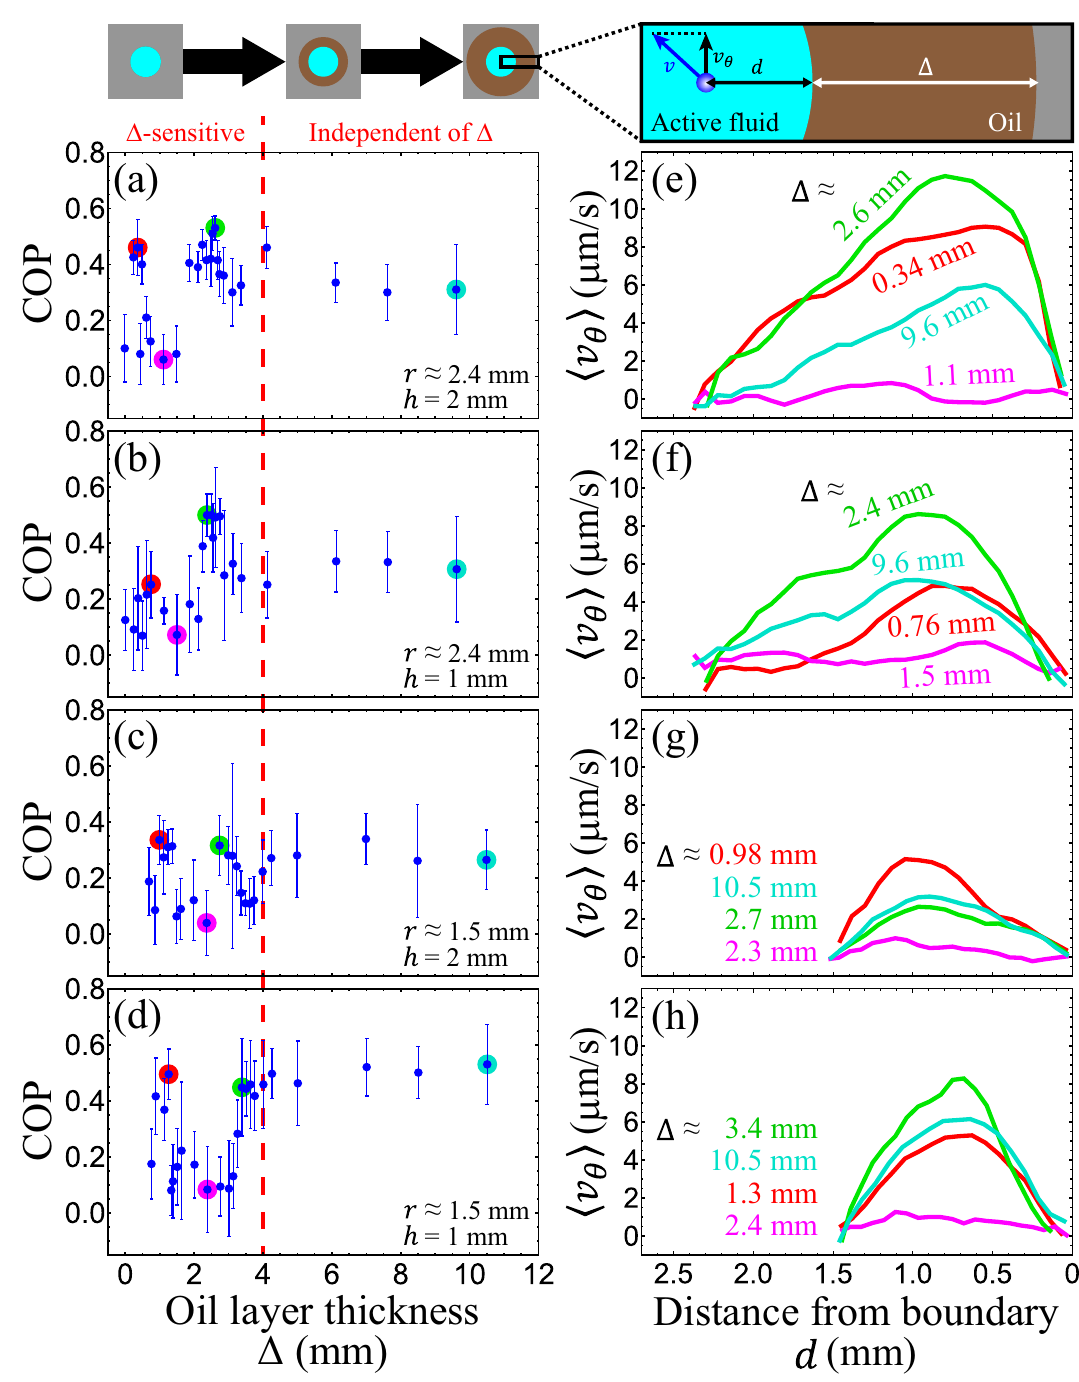
Figure 3. Intradroplet circulatory flow depended on the thickness of the surrounding oil layer, Δ. ( a – d ) The circulation order parameter (COP) as a function of Δ for four droplet shapes. Across these droplets, the intradroplet flows varied rapidly when the oil layer was thinner than ~ 4 mm (red dashed line), whereas oil layers thicker than this limit did not affect intradroplet flows. Each error bar represents the standard deviation of the time-averaged COP. ( e – h ) Flow profiles of azimuthal velocity, v θ , taken at droplet midplane. Each curve represents the averaged flow velocity of the data point shaded in the same color in the same row of a – d . These curves indicate that varying the thickness of the oil layer altered the net flow rates of the intradroplet